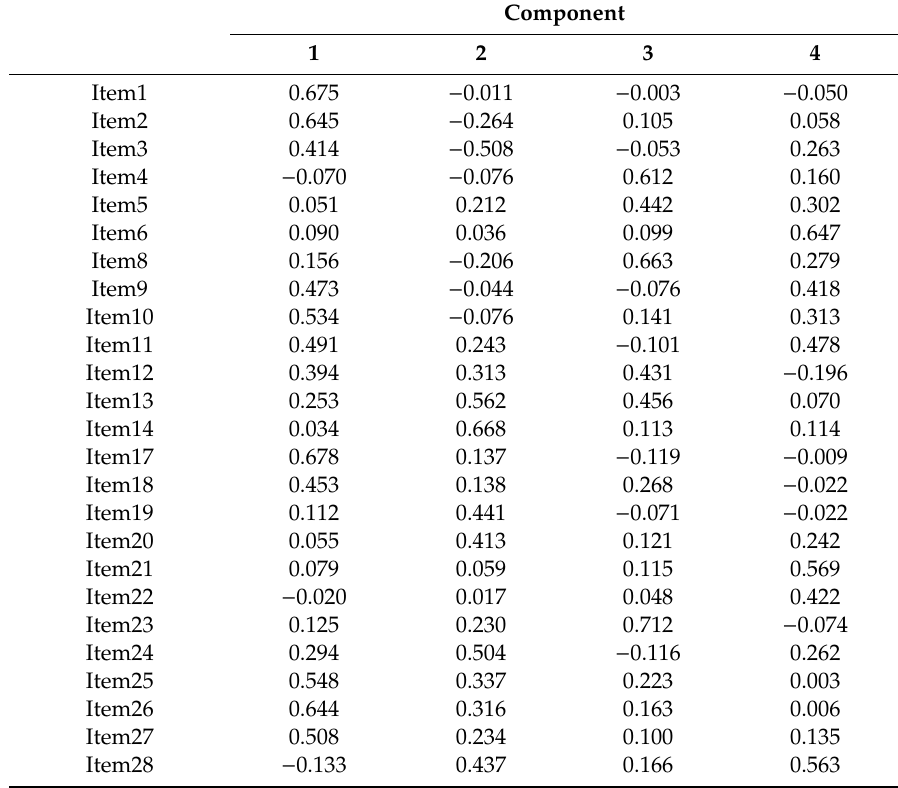
Table 4. Component rotation matrix